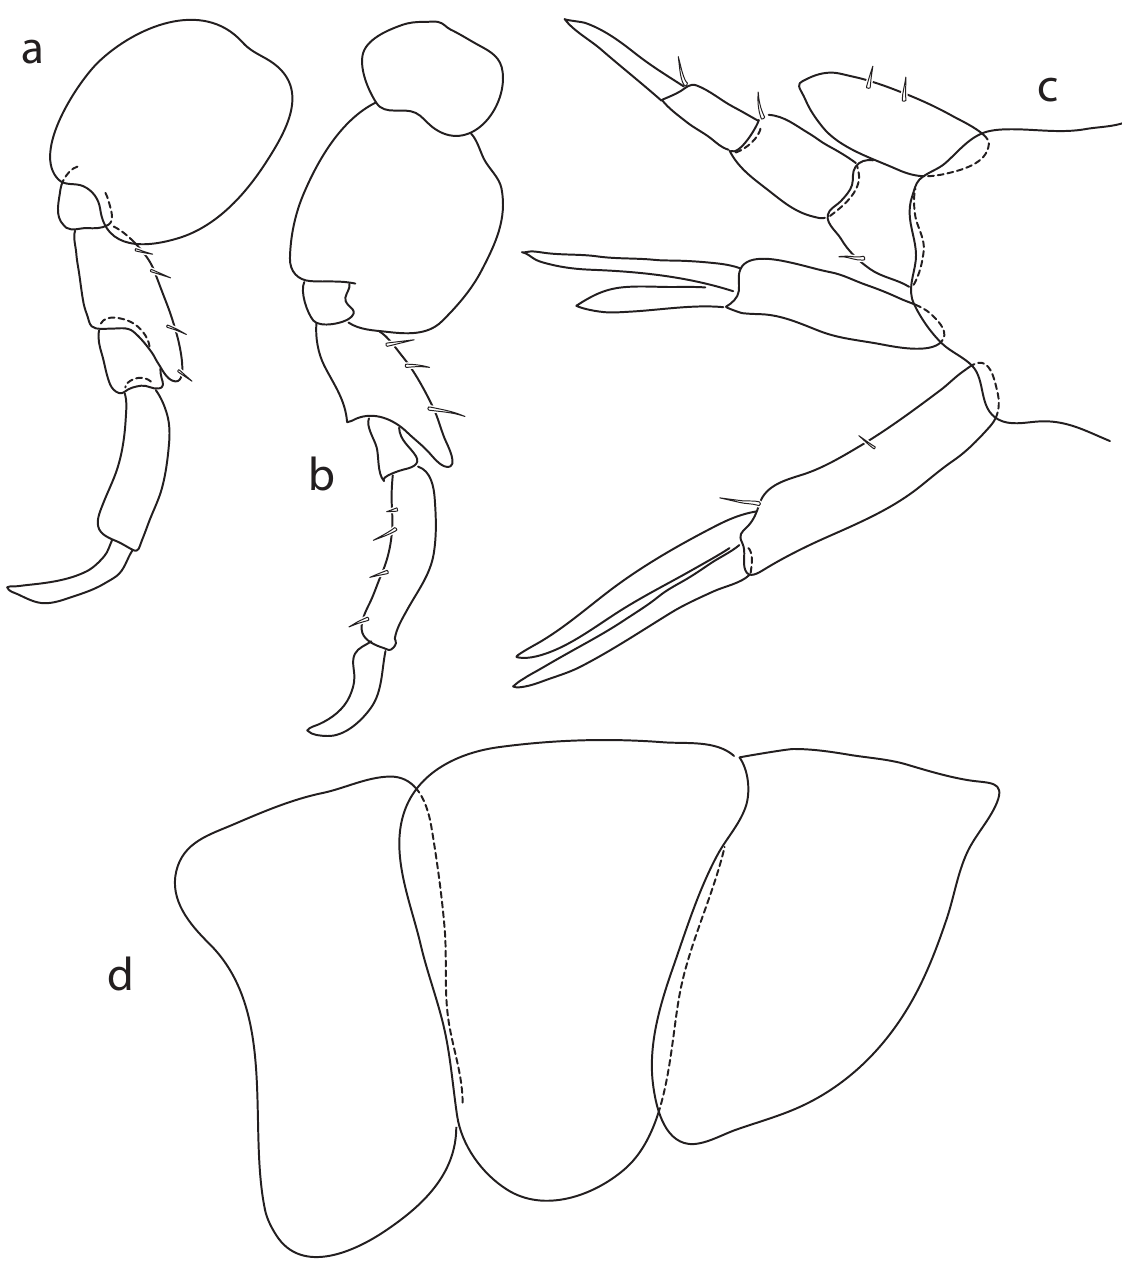
Fig. 29. Torometopa cf. c rassicornis (Schellenberg, 1931), second specimen . a . Pereopod 6. b . Pereopod 7. c . Urosome with uropods 1–3 and telson. d . Pleon segments with epimeral plates. Figure not